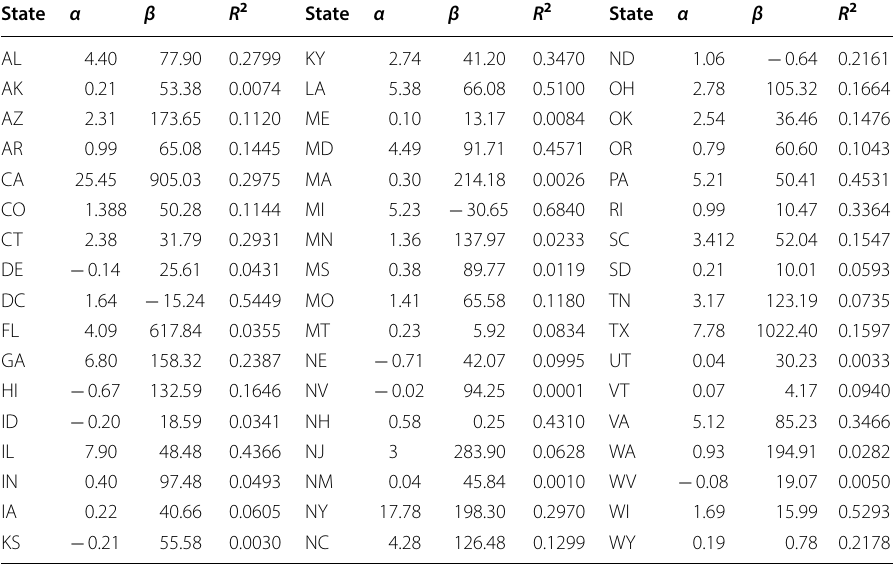
Table 8 Coefficients α , β , and R 2 of the linear regressions for Tuberculosis cases State